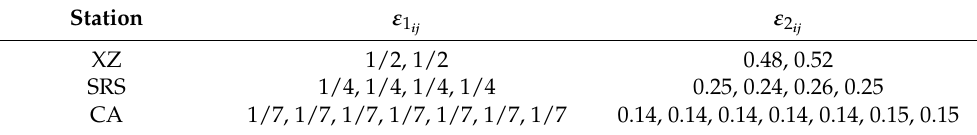
Table 6. Topology coupling strength and passenger flow coupling strength trained by GAT. Station